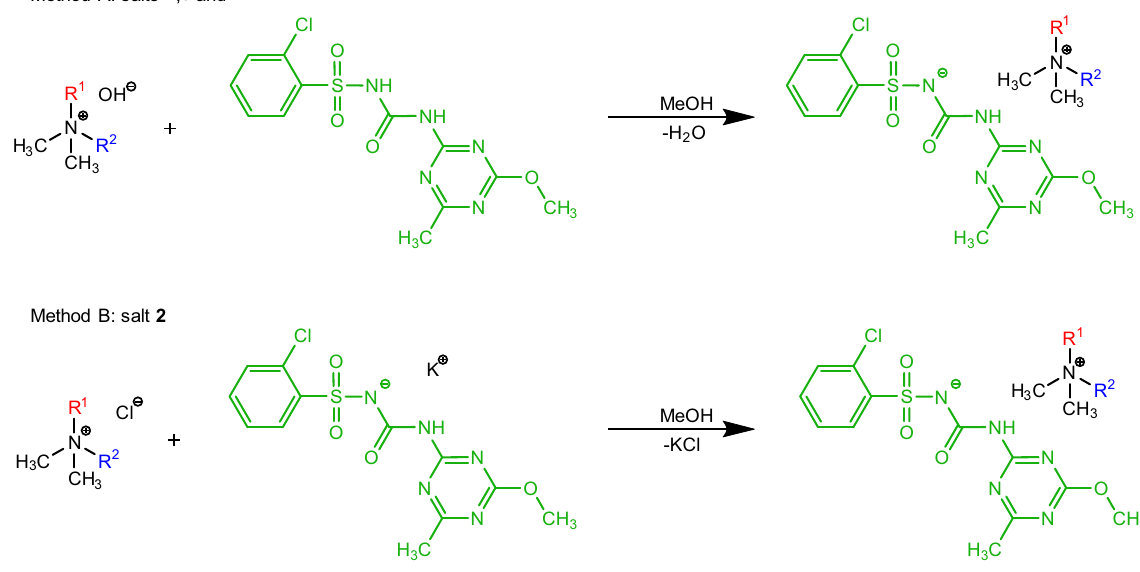
Figure 1: Synthesis of new salts comprising various tetraalkylammonium cations and chlorsulfuron as the anion ( 1 – 4 ) .